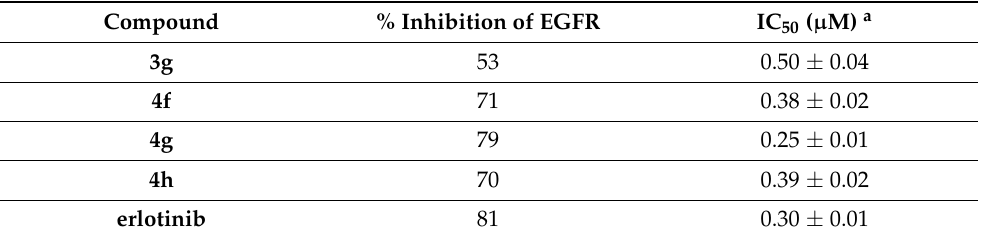
Table 3. EGFR % inhibition at 10 µ M concentration and IC 50 ( µ M) of compounds 3g , 4f , 4g , and 4h. Compound % Inhibition of EGFR IC 50 ( µ M) a 3g